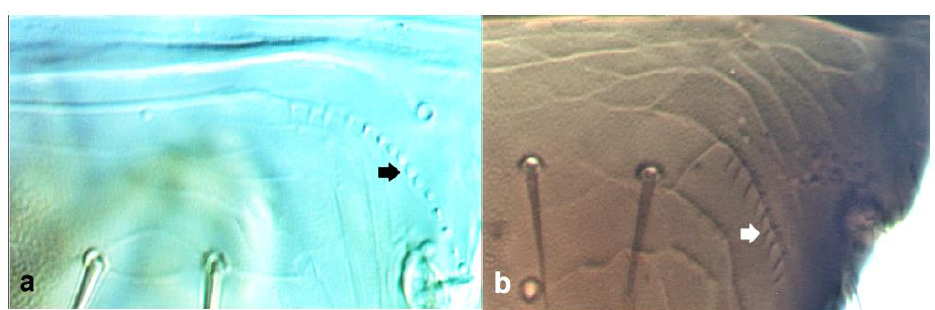
35 Ctenidia on abdominal segment VIII situated antero-laterally to spiracle (Figure 34a); anterior margin of pronotum bearing at least one pair of long setae ............................... .......................................................................................................... Frankliniella Karny .. 36 Ctenidia on abdominal segment VIII situated postero-mesad to spiracles (Figure 34b). anterior margin of pronotum with no long setae ............................. Thrips Linnaeus 37